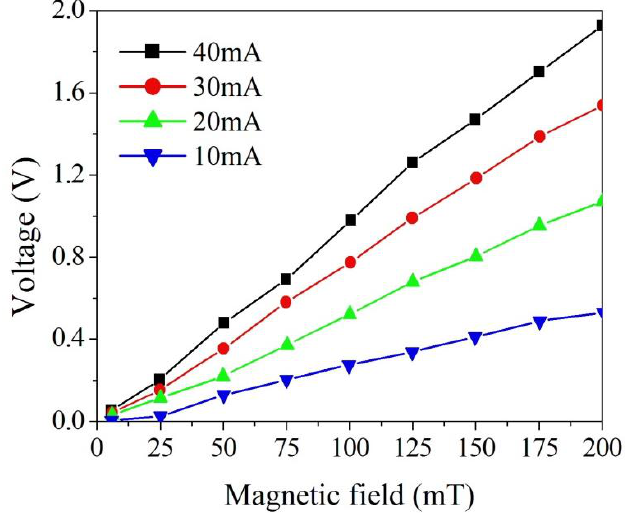
Figure 11. Output voltage of the magnetic